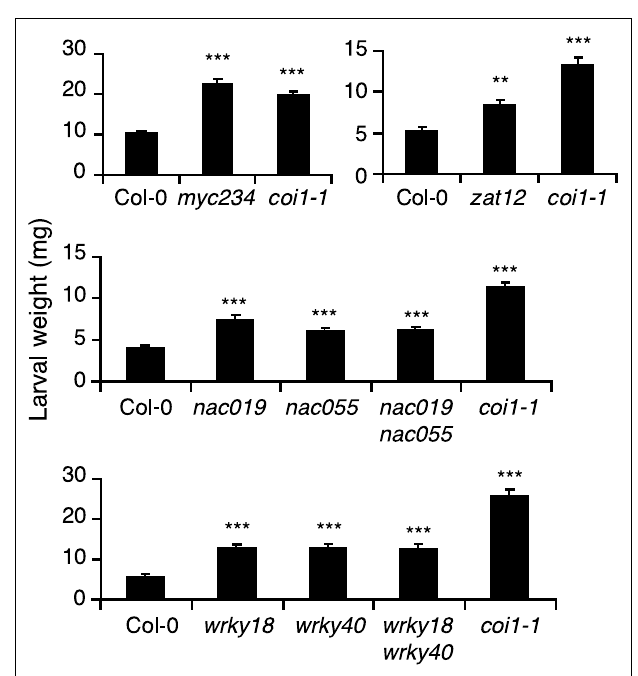
FIGURE 2 | Insect performance on transcription factor mutants. Freshly hatched S. littoralis larvae were placed on each genotype and larval weight (mean ± SE) was measured after 8days of feeding. Asterisks indicate statistically significant differences between mutant plants and